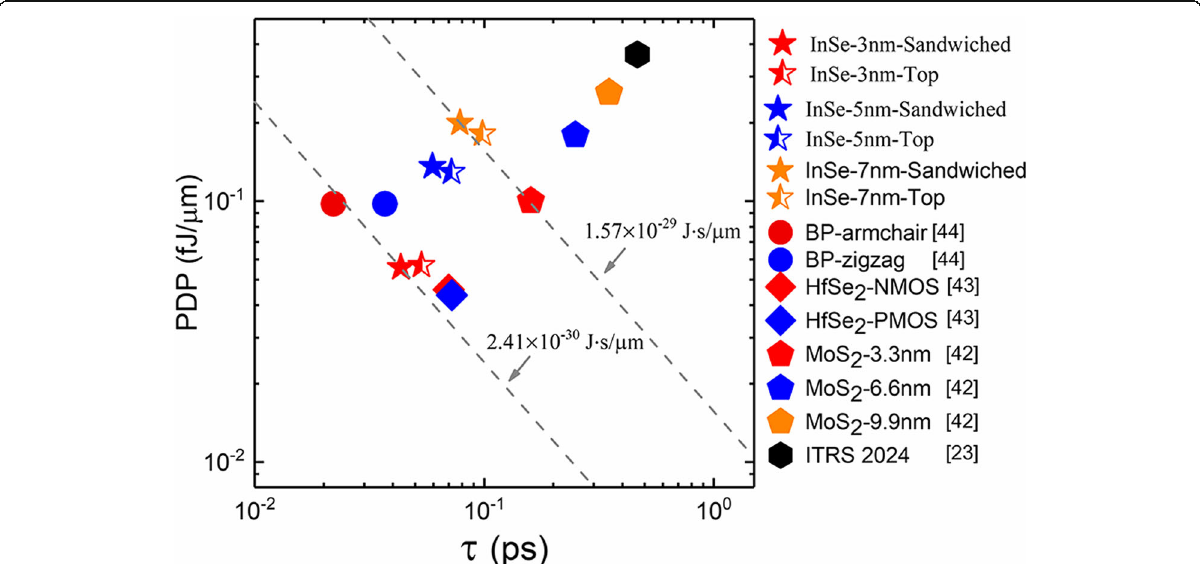
Fig. 7 Power-delay product versus intrinsic delay comprised of InSe and other 2D FETs. The gray dashed guidelines correspond to specific